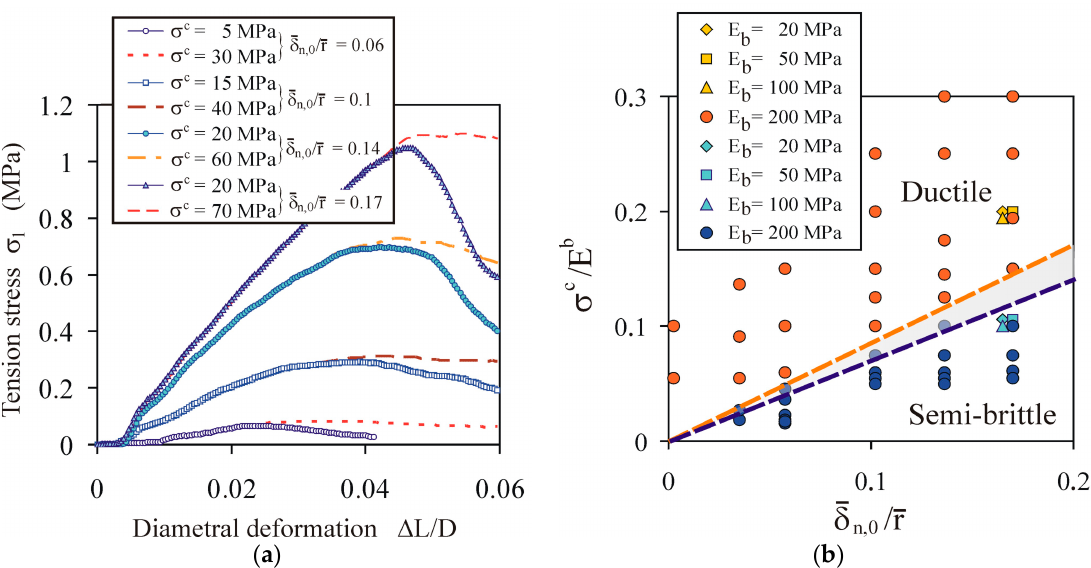
Figure 8. Effect of the σ c / E b ratio on the breakage behaviour of the agglomerates during diametral compression: ( a ) comparison of the tension stress vs. diametral deformation σ 1 ( Δ L / D ) for the ductile and semi-brittle breakage modes at E b = 200 MPa; ( b ) ( σ c / E b , δ n ,0 / r ) map of the ductile and semi-brittle behaviour of the agglomerates.